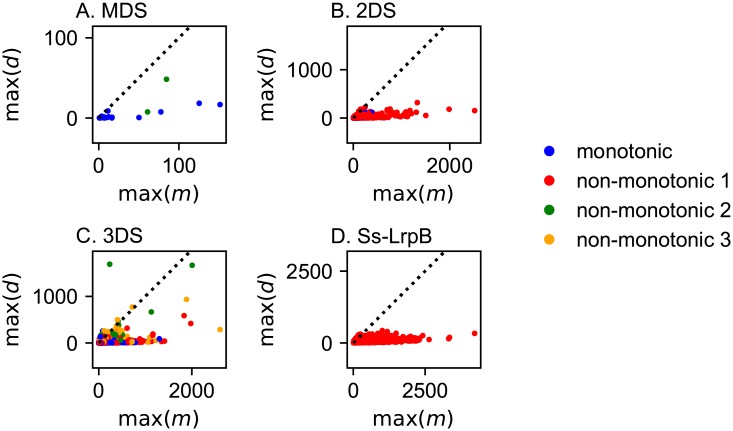
Amplitudes of oscillation in the monomer (m)—dimer (d) plane for the different toy models.The dashed line represents same copy number of monomer and dimer. Oscillations for the MDS are small: the dimer copy number does not exceed 50. The copy number of the monomer is higher than the copy number of the dimer for the majority of the solutions for all systems, contrarily to what is observed in prokaryotic systems in nature.